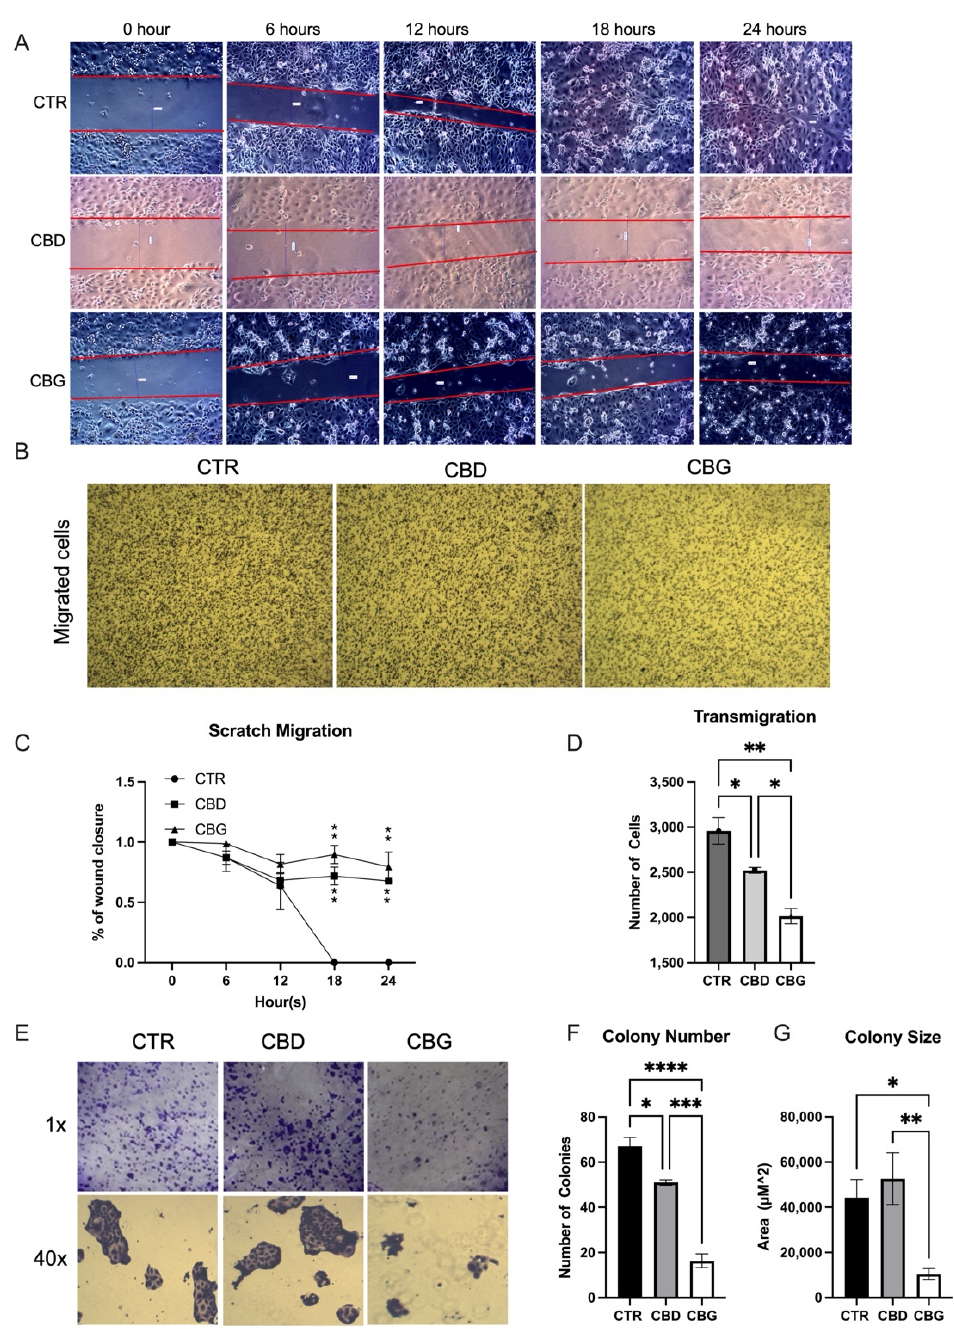
Figure 2. CBG treatment inhibited the wound healing and migration: ( A ). scratch migration assay, the diameter of the wound was measured every 6 h over a 24-h period; ( B ). micrographs showing cells plated in a Transwell 48 h after seeding and treatment with either 0.1% DMSO (CTR), 100 μ M CBD or 100 μ M CBG; ( C ). percentage of wound closure relative to the initial size of the wound; significant difference at 18 h and 24 h in treatments (CBG and CBG) vs. control; ( D ). quantification of colonies using ImageJ shows a significant decrease in cell migration number in CBD treatments and a significant decrease from CBD to CBG treatment; ( E ). colonogenic formation assay showing cells 7 days after being plated as single cell colonies and then treated with CTR, CBD or CBG (100 μ M) for 24 h; ( F , G ). quantification of colonies shows a decrease in colony formation number in both CBD and CBG treatments and a significant decrease in colony size with CBG treatment. * P < 0.05 vs. CTR, ** P < 0.01 vs. CTR, *** P < 0.001 vs. CTR, **** P < 0.0001 vs. CTR . 3.3. Cannabidiol and Cannabigerol Induce Cell Death by Different Mechanisms, through Au- tophagic Pathways and Apoptotic Pathways, Respectively